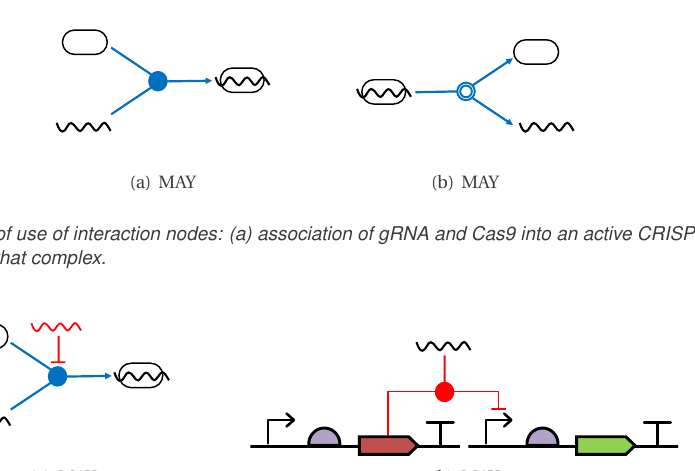
Figure 19: Examples of use of multi-head and multi-tail arrows: (a) Repression from multiple independent sources and (b) repressor with multiple targets. (c) Multi-head interactions, however, MUST NOT use different glyphs for different heads.